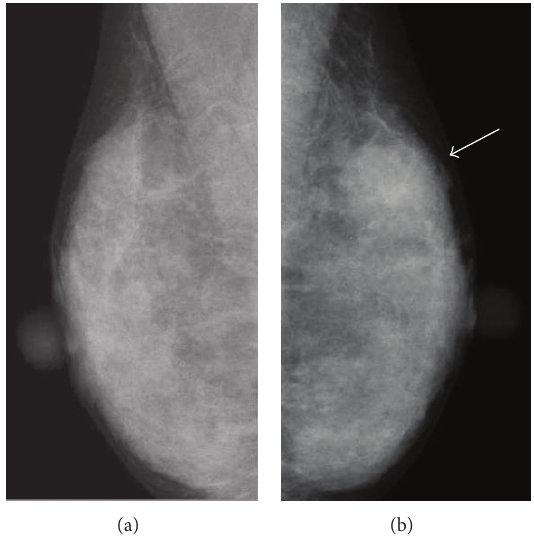
Figure 1: Mammography revealed a focal asymmetric density (arrow) in the lateral upper quadrant of the left breast.